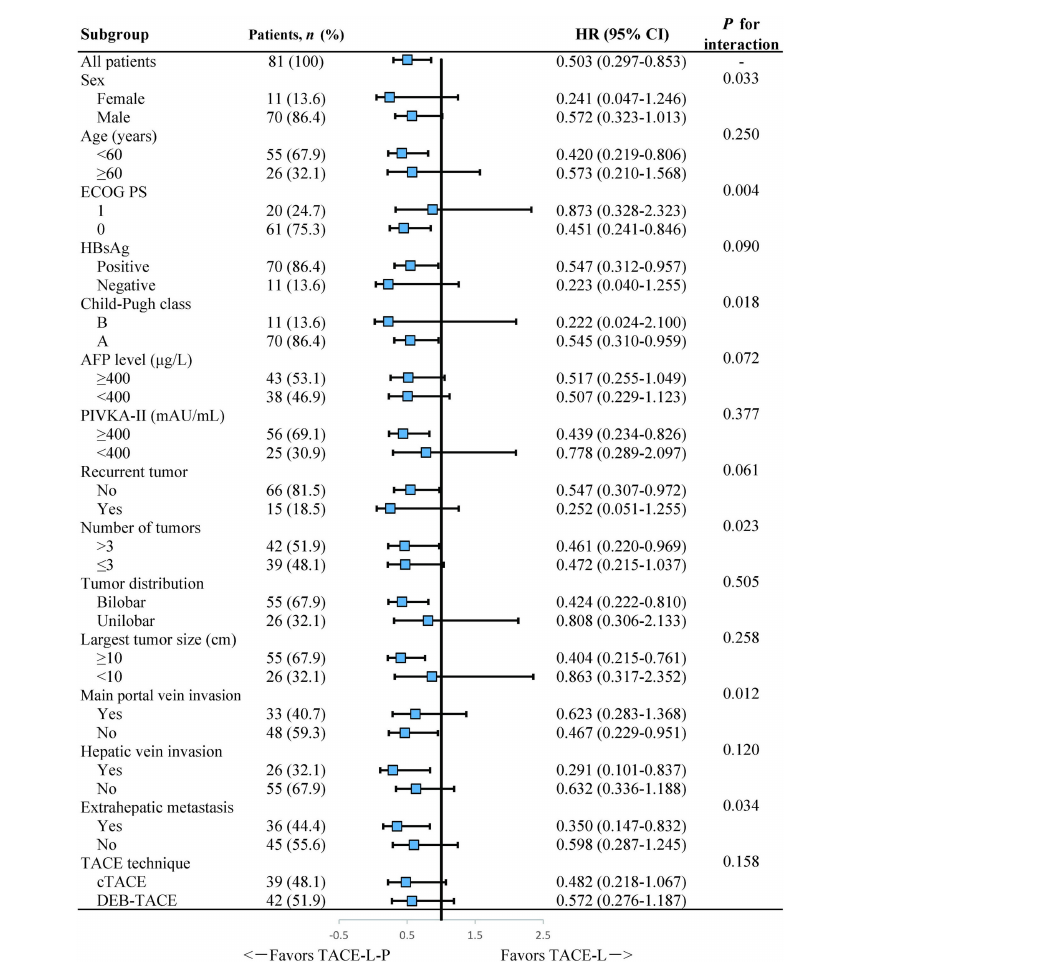
FIGURE 3 | Forest plot of the subgroup analyses for overall survival. HR, hazard ratio; CI, con fi dence interval; ECOG PS, Eastern Cooperative Oncology Group Performance Status; HBsAg, hepatitis B surface antigen; AFP, a -fetoprotein; PIVKA-II, protein induced by vitamin K absence or antagonist-II; TACE, transarterial chemoembolization; cTACE, conventional transarterial chemoembolization; DEB-TACE, drug-eluting bead transarterial chemoembolization; TACE-L-P, transarterial chemoembolization combined with lenvatinib plus PD-1 inhibitor; TACE-L, transarterial chemoembolization combined with lenvatinib.